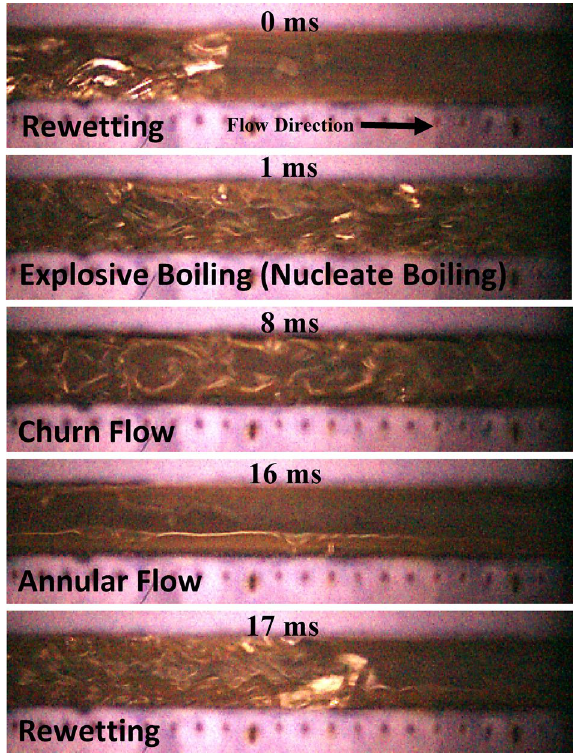
Figure 8. Flow pattern transitions of flow boiling in SiNW microchannels at mass flux, 400 kg/m 2 s and heat flux, 48 W/cm 2 using dielectric fluid, HFE-7100 at frame rate 50,000